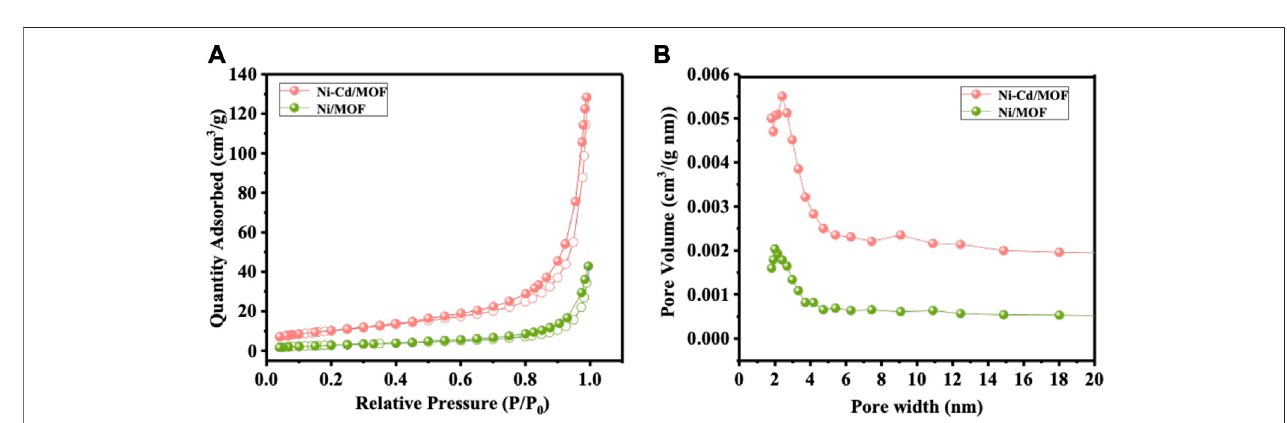
FIGURE 4 | (A) N 2 adsorption and desorption isotherms; (B) pore size distribution of Ni-MOF and